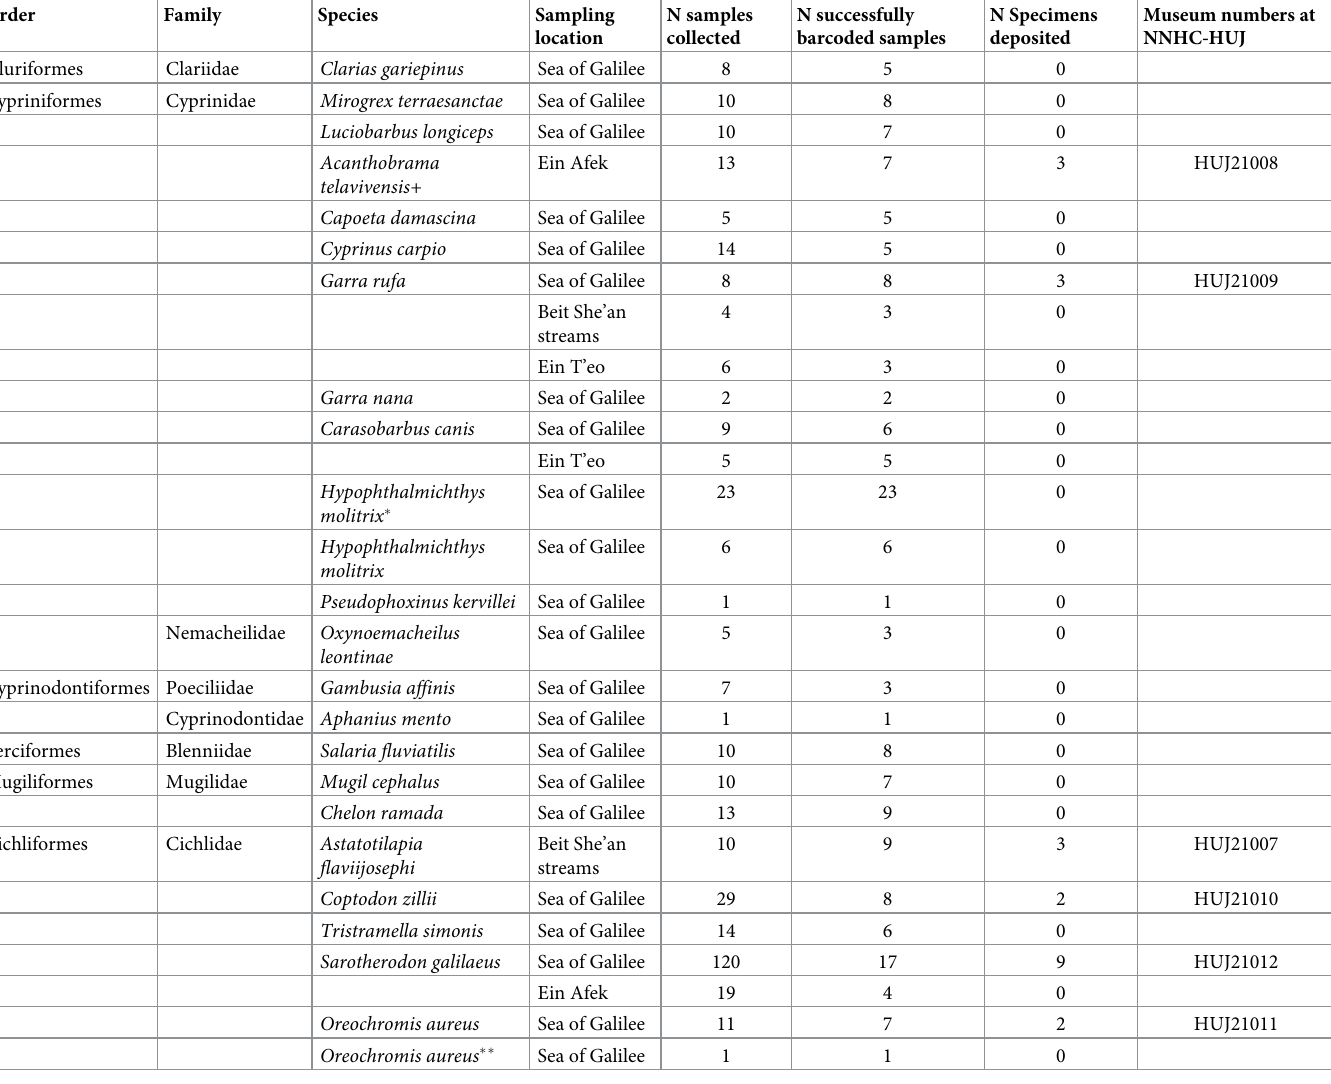
Table 1. Fish species collected, barcoded and deposited at the National Natural History Collections of the Hebrew University of Jerusalem (NNHC-HUJ) by species and location.